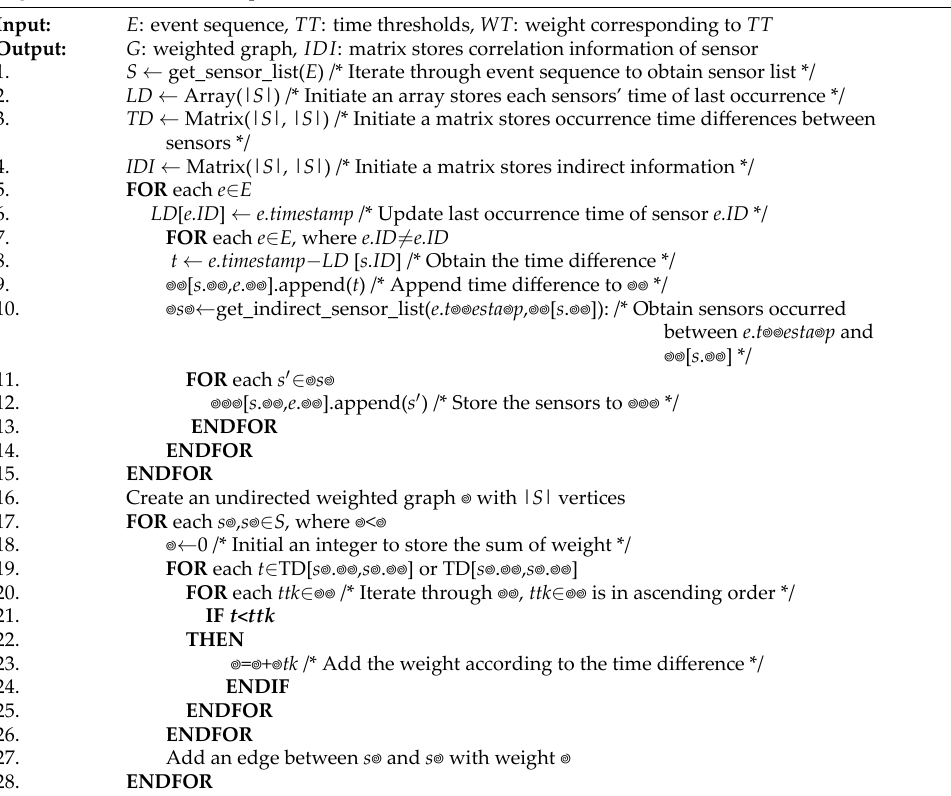
Algorithm 2 Correlation Graph